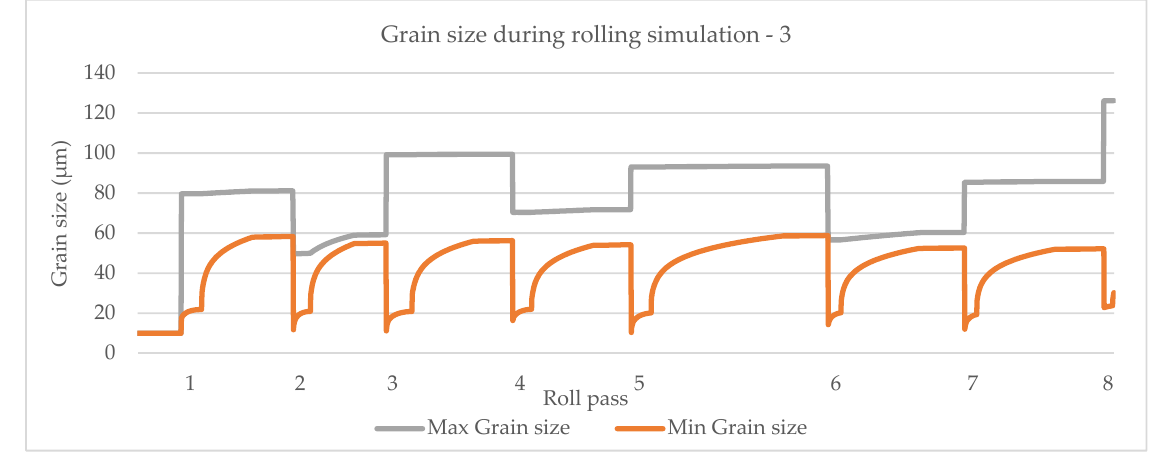
Figure 15. Simulation of maximum and minimum grain size based on the model by Yada [12].